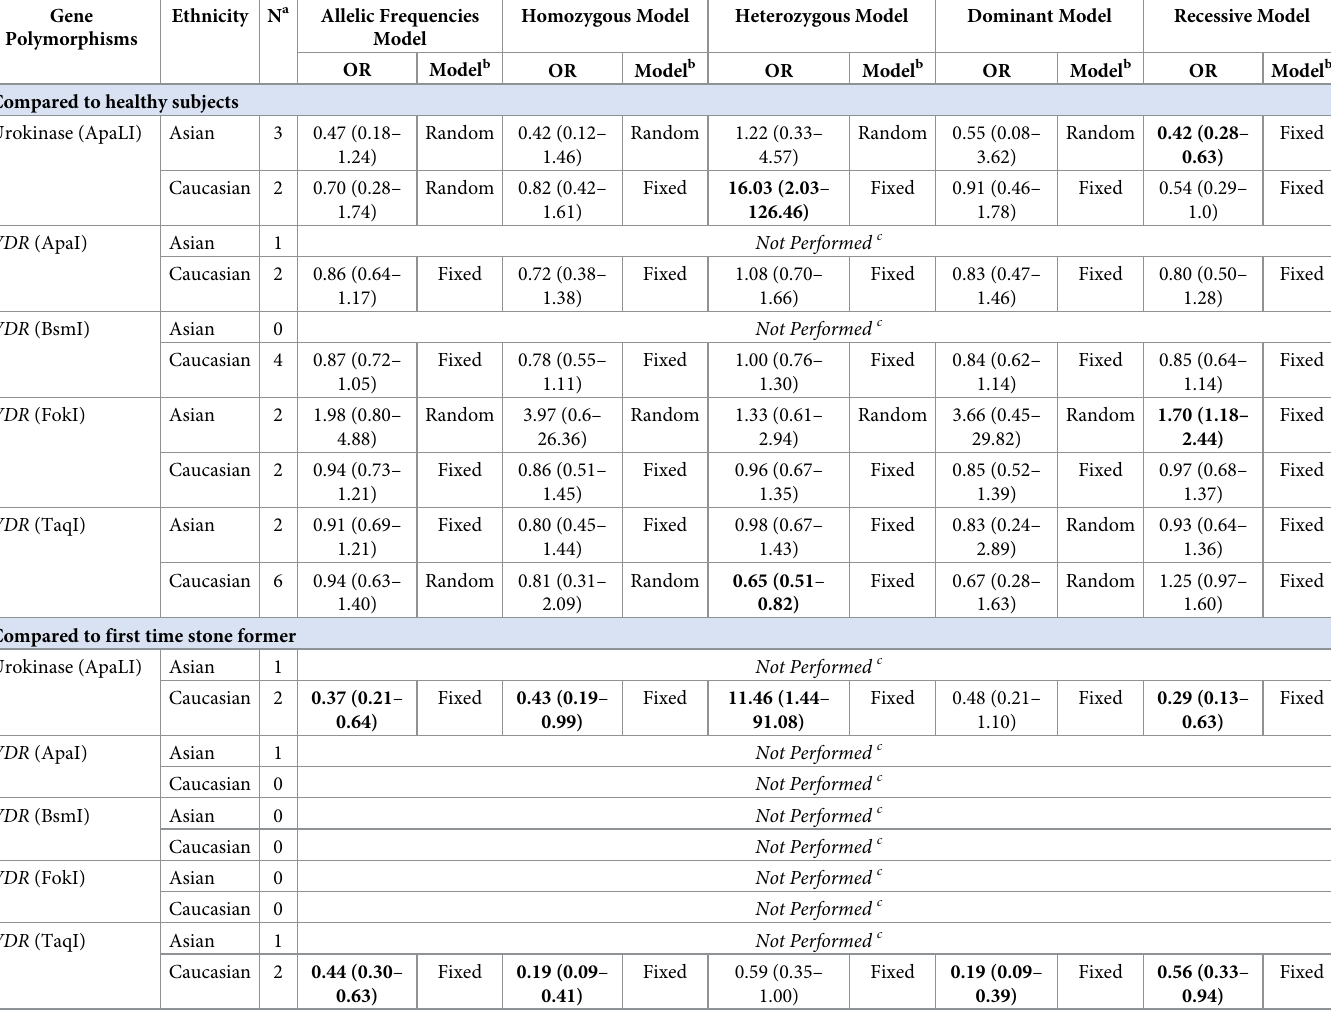
Table 6. Sub–analysis between the urokinase (ApaLI) and VDR (ApaI, BsmI, FokI, and TaqI) gene polymorphisms and recurrent kidney stones among Asian and Caucasian ethnicity.